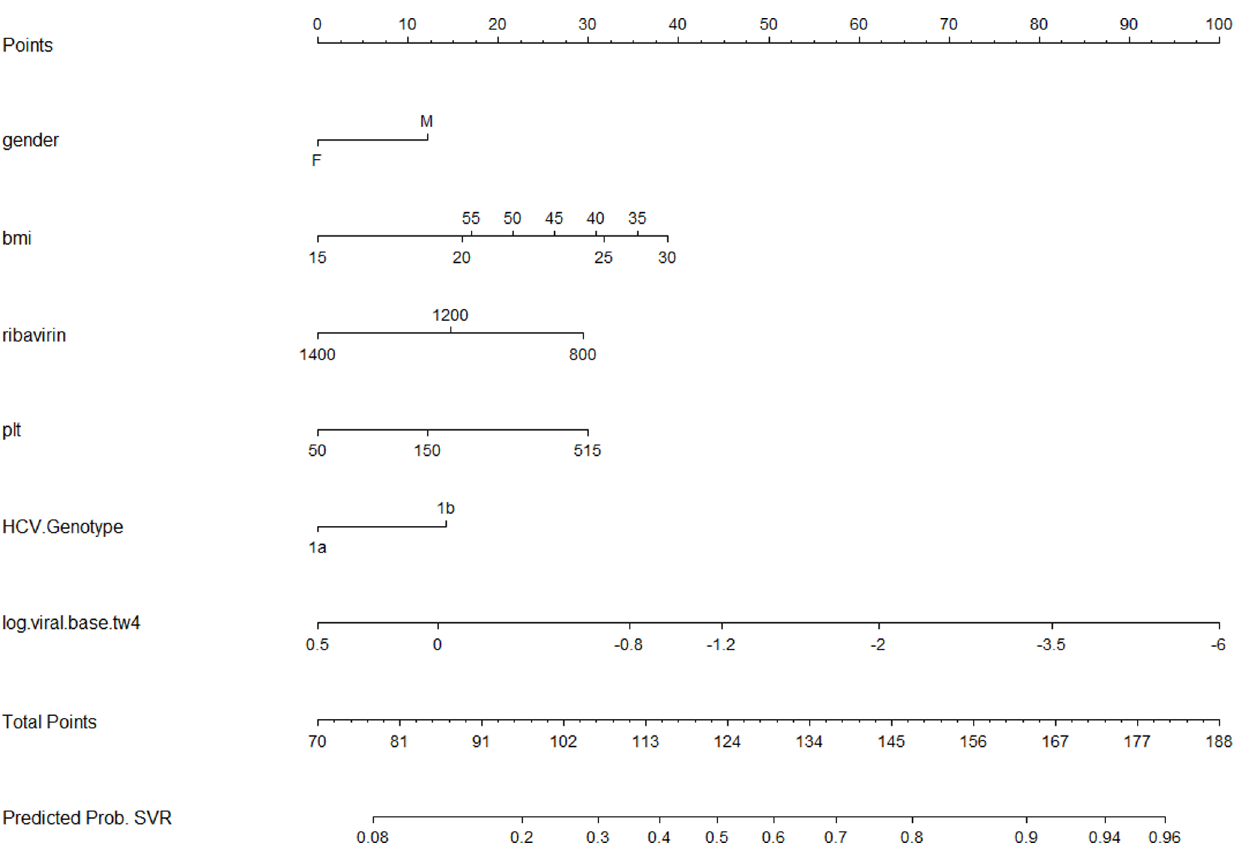
Figure 2. Nomogram for predicting SVR in null responders, partial responders, relapsers and previously untreated patients treated with Boceprevir + PR.